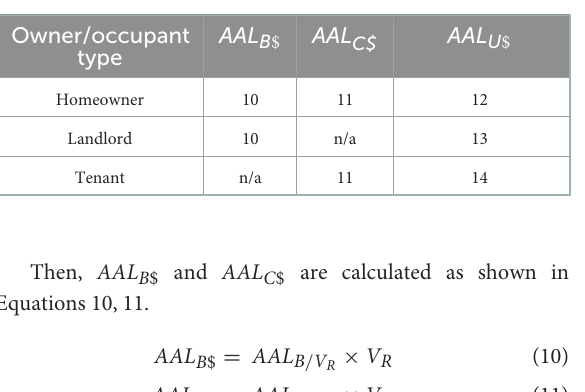
TABLE 1 Equation numbers used to calculate building, contents, and use average annual loss ( AAL B $ , AAL C $ , and AAL U $ ) by owner/occupant